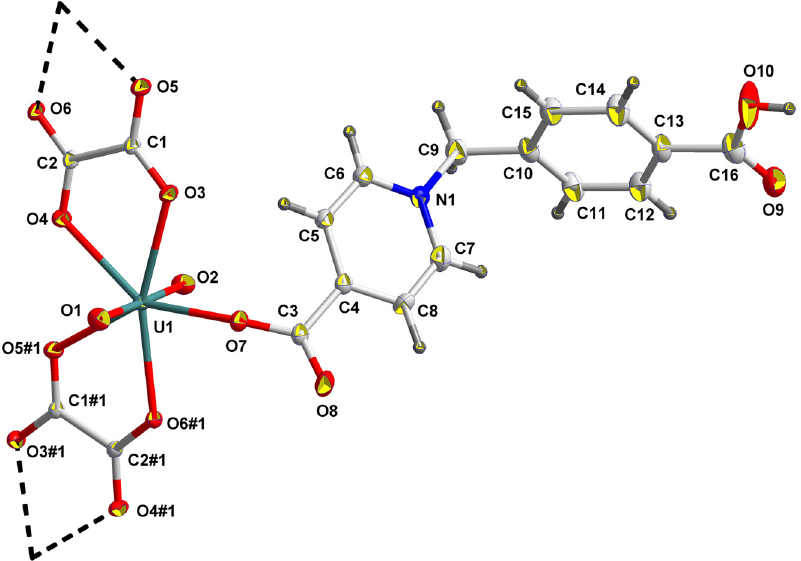
Table  : Data collection and handling. Crystal: Yellow